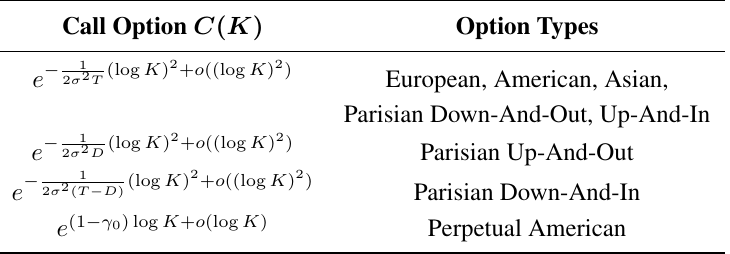
Table 1. Summary of four categories for call option prices at extreme strikes, where T is the > 1 is a constant depending on r, q, σ maturity, D is the option window and γ 0